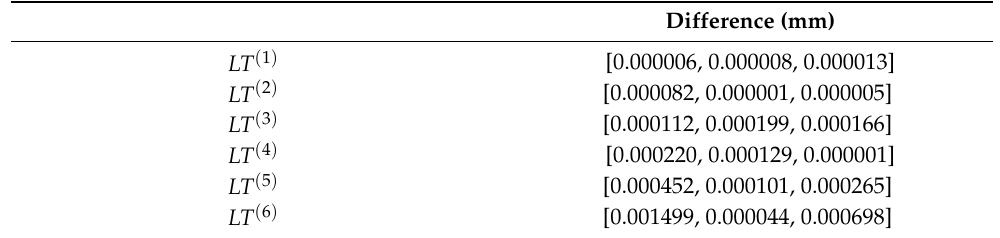
Table 6. Difference values from Table 5.